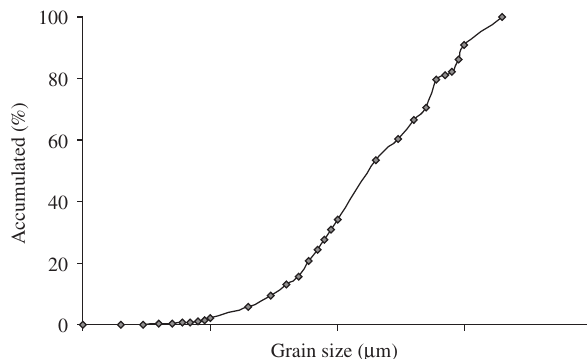
Figure 2. Particle size distribution of the grinding dust used in the tests.